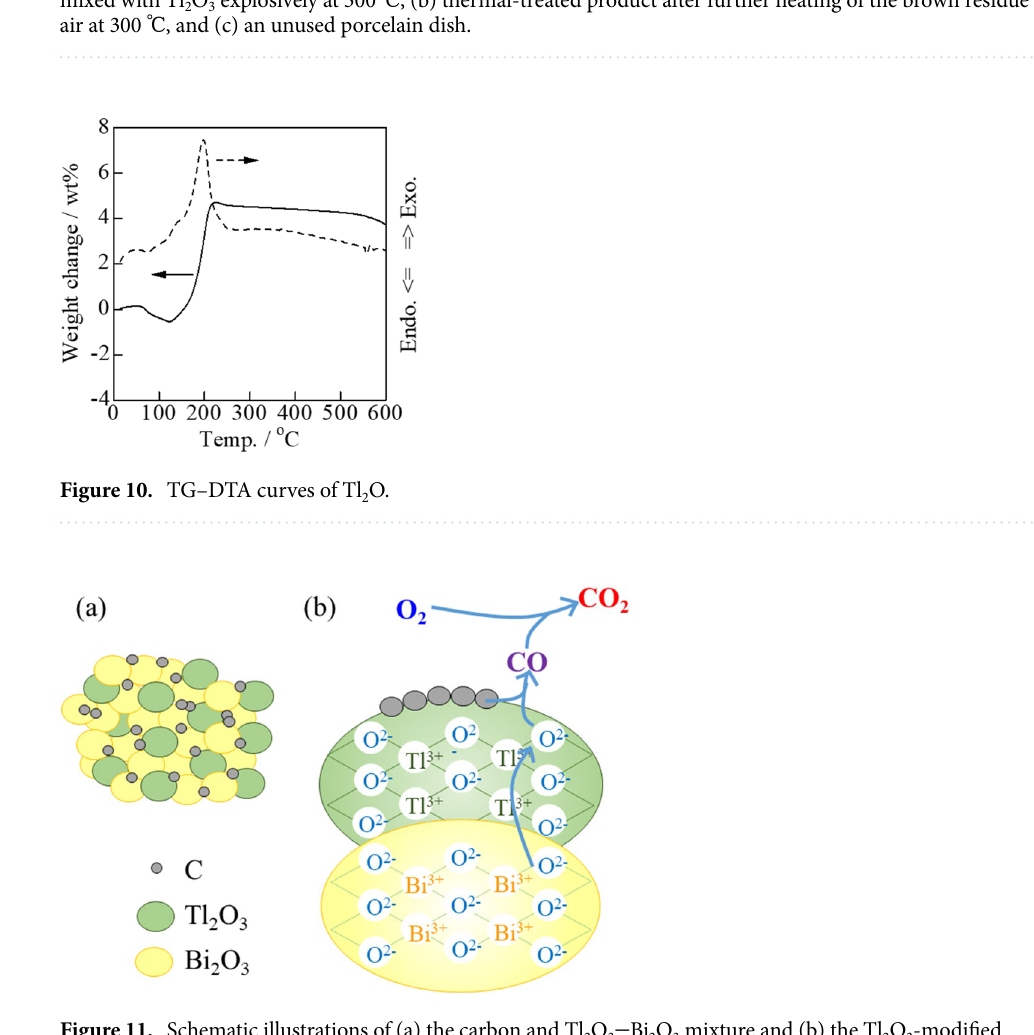
Figure 9. XRD analysis of the surface of porcelain dish. (a) Brown residue after reacting carbon black (5 wt%) mixed with Tl